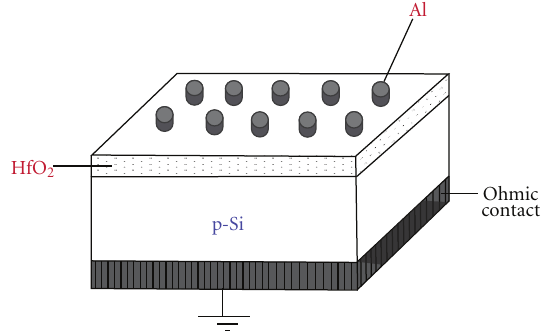
Figure 1: Schematic diagram of Al/HfO 2 /p-Si (MOS) structure.